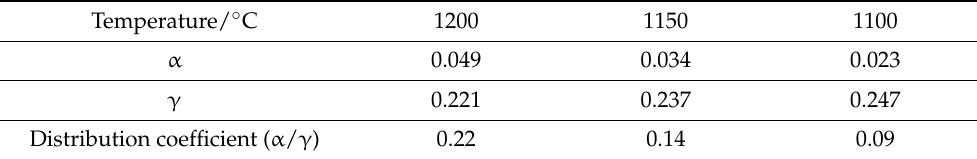
Table 3. N contents in α and γ under different temperatures in S32750 (mass.